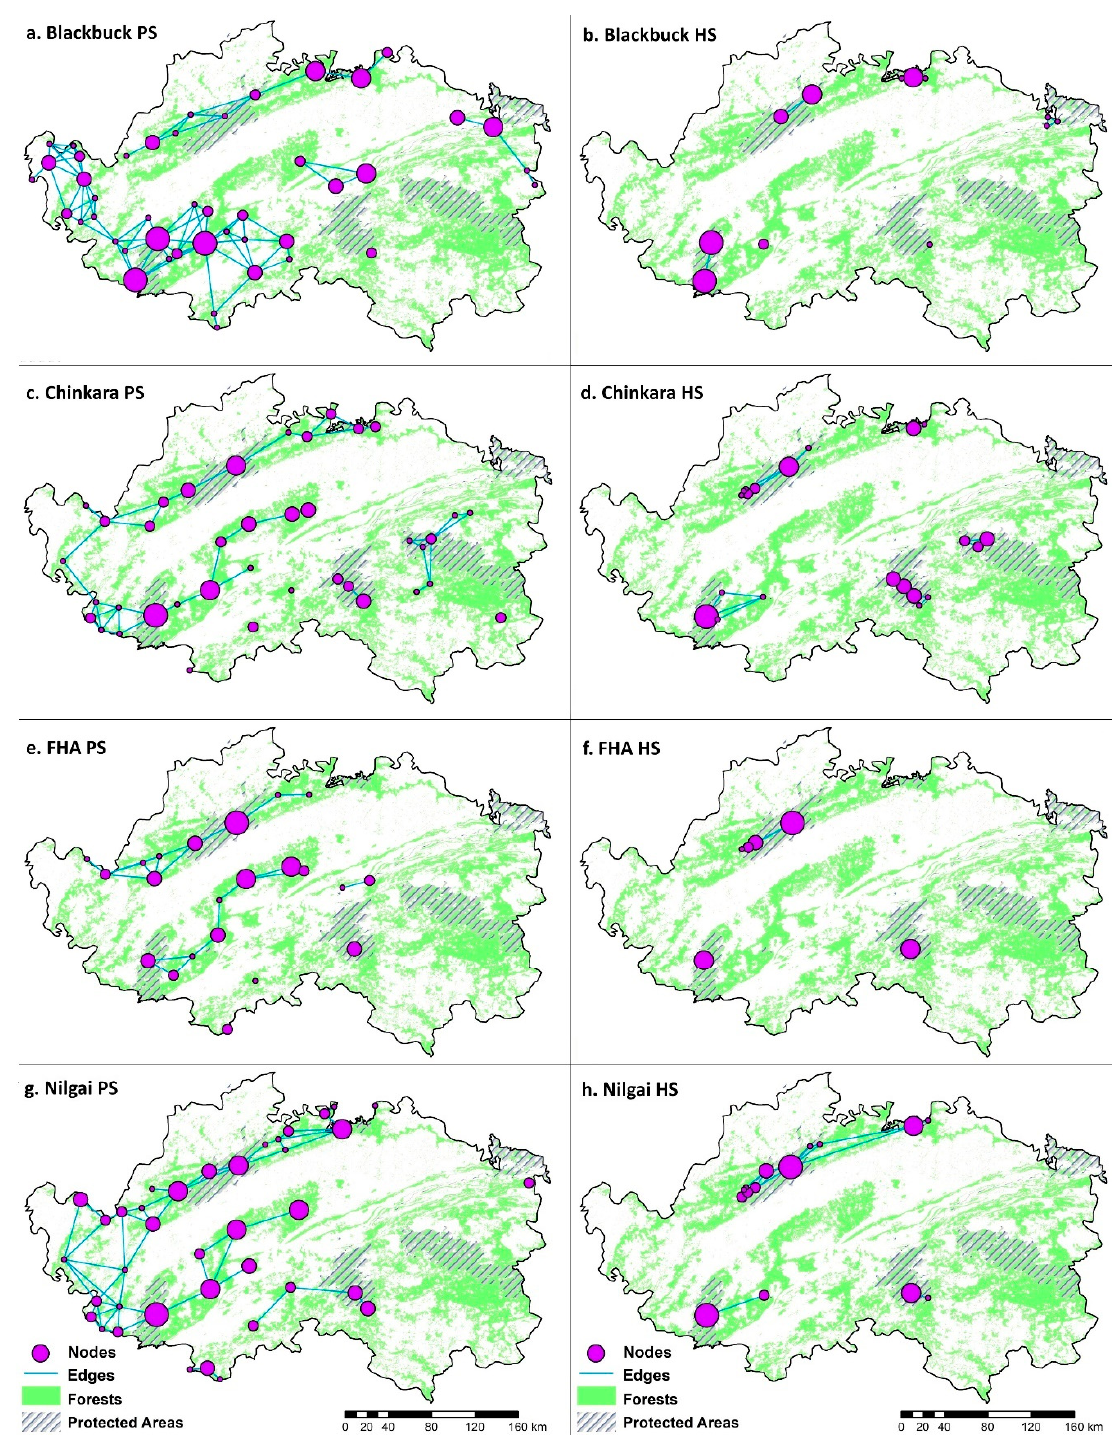
Figure 9. A topologic representation of antelope core habitats and links. Core habitat patches are shown as nodes while the connections between nodes are shown as edges. The size of the nodes is proportional to the areas of the different habitat patches. The left panels represent the present scenario (PS) while the panels to the right represent a hypothetical future scenario (HS) in which the core habitats exist only in protected areas. ( a ) Blackbuck PS; ( b ) Blackbuck HS; ( c ) Chinkara PS; ( d ) Chinkara HS; ( e ) FHA PS; ( f ) FHA HS; ( g ) Nilgai PS; ( h ) Nilgai